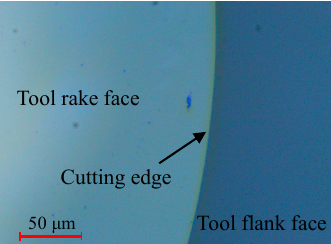
Figure 1. Check of the defects-controlled cutting edge by an optical microscope at 1250 magnification.